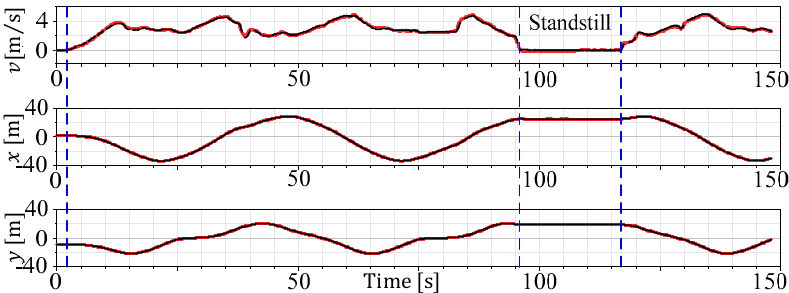
Figure 21. Experiment with vehicle standstill estimation (red) vs. reference (black).